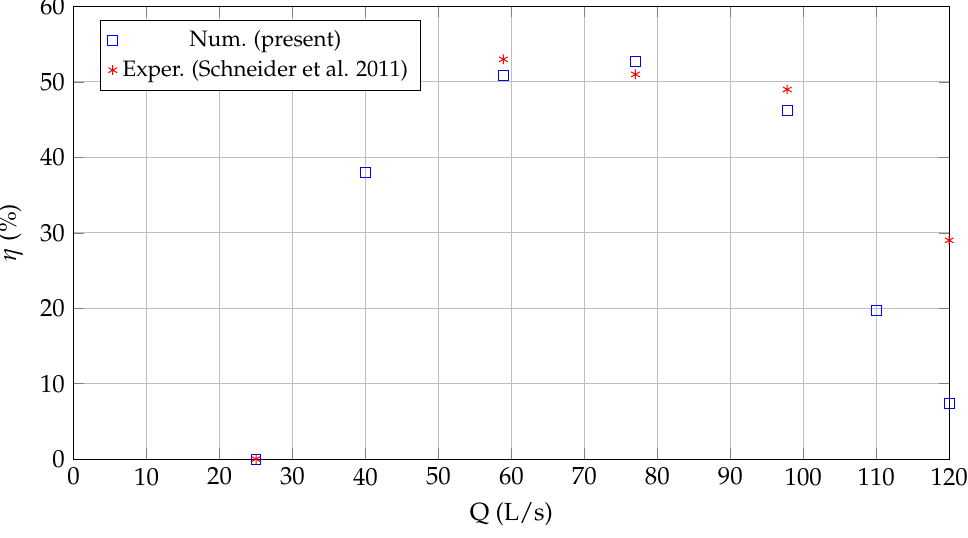
Figure 15. Efficiency—Discharge curve of the HPM. Comparisson of numerical with experimental results presented in Schneider et al. (2011)